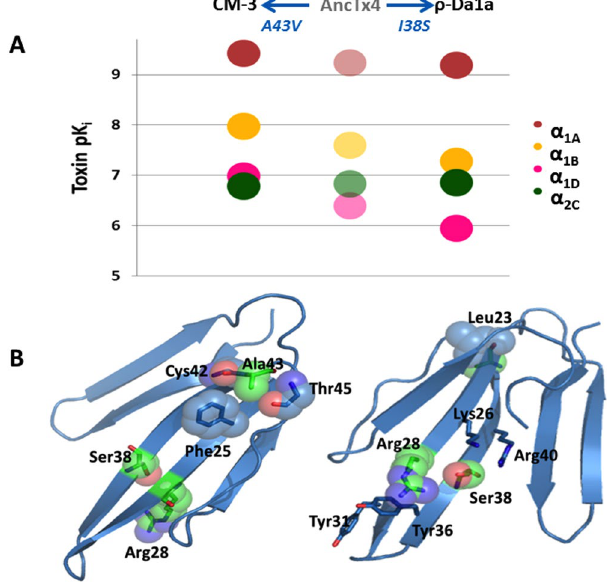
Figure 6. Affinity and structure analysis of CM-3, AncTx4 and ρ -Da1a toxins on adrenoceptors. ( A ) pK i values are reported for CM-3, AncTx4 and ρ -Da1a on the 4 adrenoceptors α 1A , α 1B , α 1D and α 2C . ( B ) The X-ray structure of ρ -Da1a K34A (code PDB: 4IYE), the position 43 is in the top of the third loop quite far and on the opposite side compare to the substitution S38I. The lateral chain of Ala43 is surrounded by the phenyl ring of Phe25, the side chain of Leu23, and by oxygen atoms from Cys42 and Thr45 main chains. This region of the globular core is indeed compact. Hence the substitution A43V has to reorganize the packing to accommodate the bigger lateral chain of the valine.